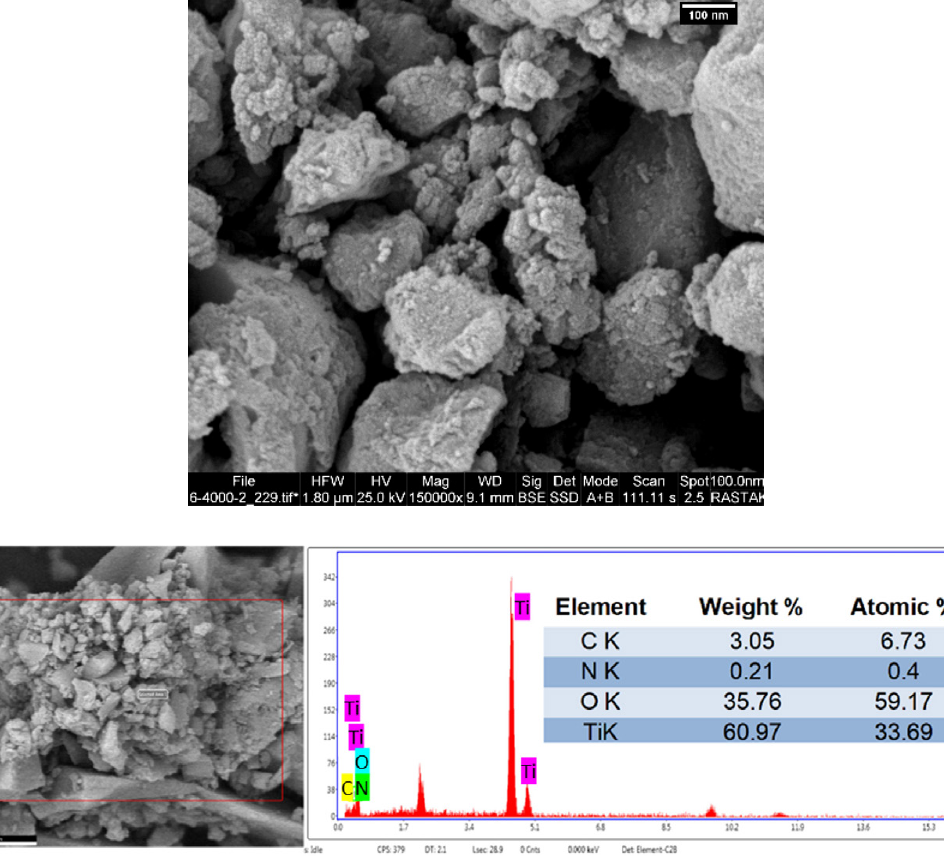
/C nanocomposite. 2